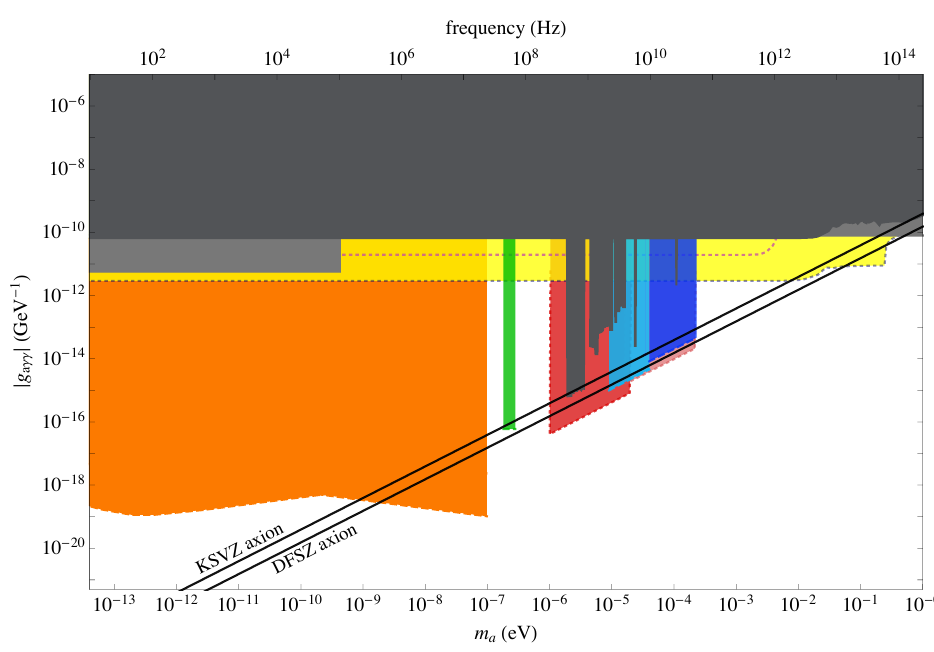
Figure 2 . Existing and future constraints on the axion-photon coupling. The lighter grey regions are existing constraints from horizontal branch stars [35] and SN1987A [36], while the darker grey regions are those from CAST [14], ADMX [37, 38], RBF and UF [39{41], HAYSTAC [11], and ORGAN [42]. Future constraints are expected from proposed and ongoing experiments: IAXO [16] (yellow) , ALPS-IIc [15] (pink dotted line) , ADMX [10] (red) , ADMX-HF [43] (pink) , CULTASK [44] (light blue) , RADES (prototype) [45] (purple) , MADMAX [46] (dark blue) , KLASH [47] (green) , and ABRACADABRA [12] (orange) . The black lines show the expected axion-photon coupling for the KSVZ and DFSZ axion, both of which have g a(cid:13)(cid:13) (cid:24) (cid:11)= (2 (cid:25)f a ) (cid:24) (cid:11)m a = (2 (cid:25) (cid:3) 2 QCD